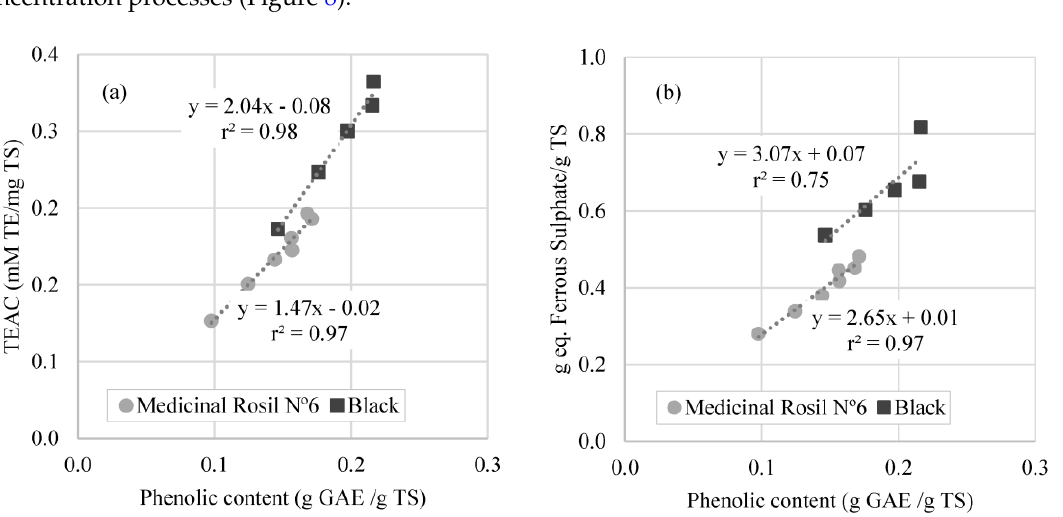
Figure 8. Correlation between phenolic content and antioxidant activity measured by ( a ) DPPH method; ( b ) FRAP method.